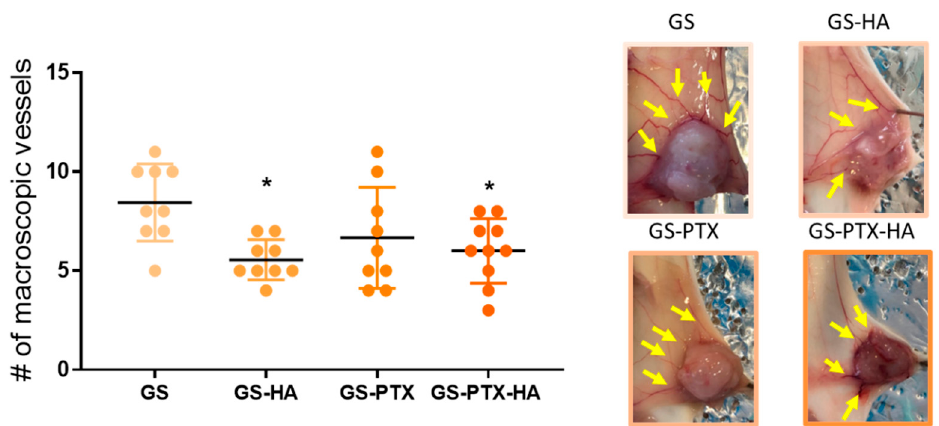
Figure 7. Number of macroscopic vessels. Scatter dot plots represent the median and interquartile range. ANOVA and Tukey’s multiple comparisons test, * p < 0.05 vs. GS. Representative images of the tumors are shown. Arrows indicate vessels.